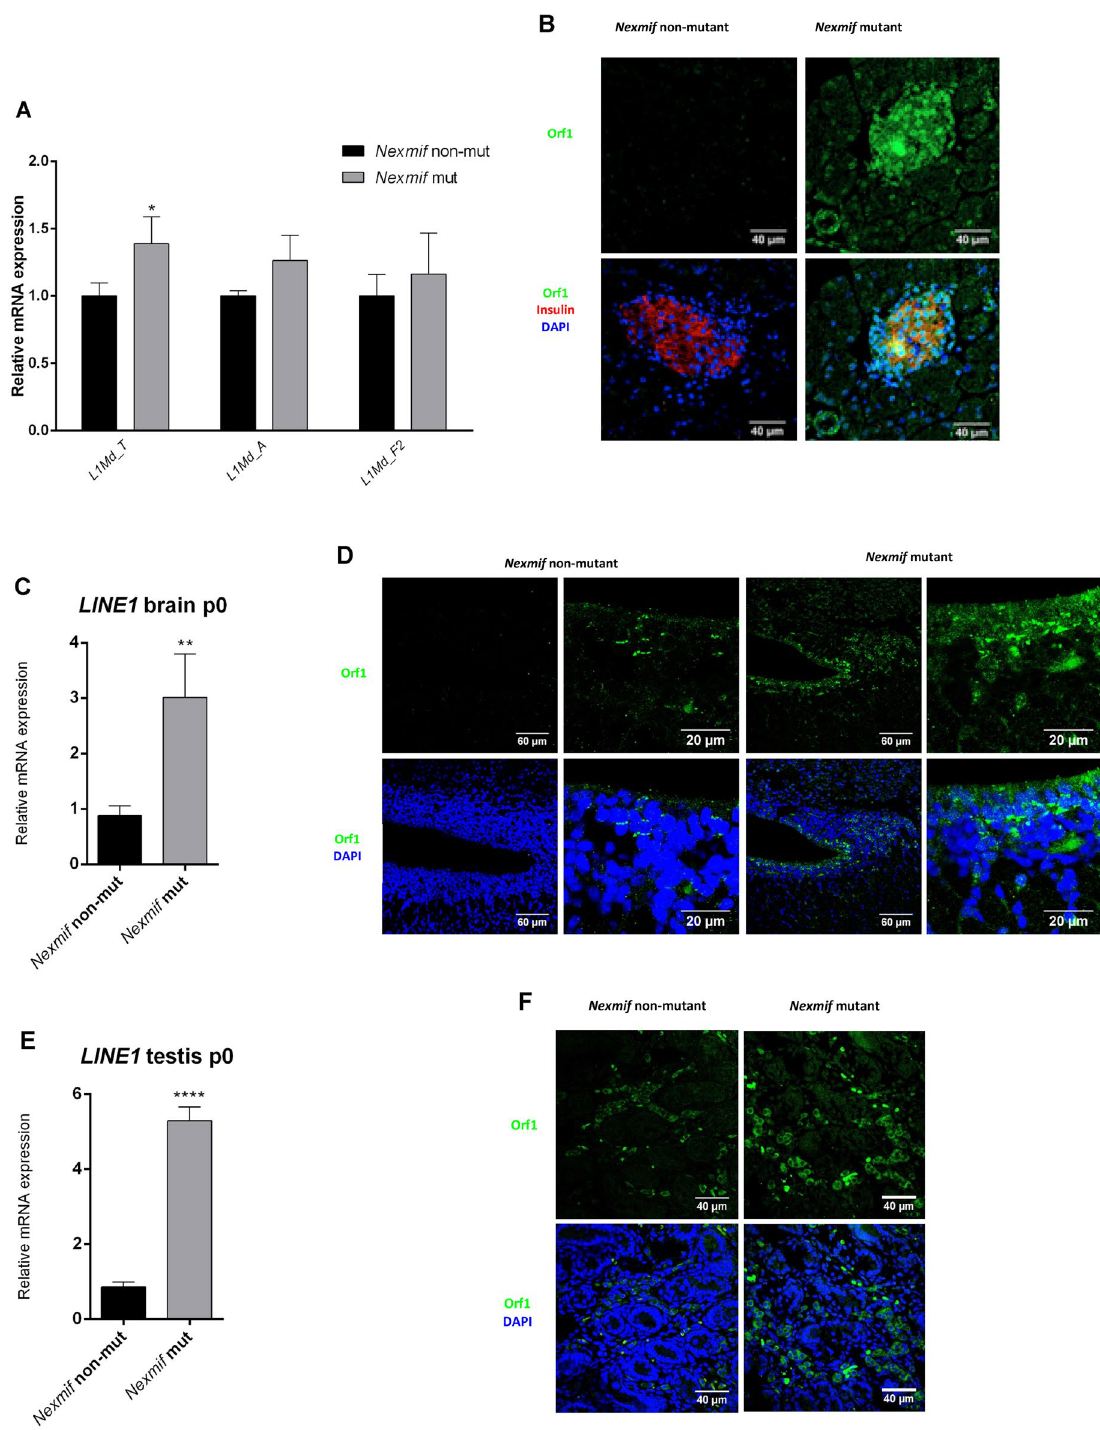
Figure 7. LINE1 activation. ( A ) RNAseq expression data for transposable LINE1 elements in pancreatic islets of 6-week-old Nexmif mutant and non-mutant mice (n = 3). ( B ) ORF1 protein (green) expression in Nexmif mutant and non-mutant mouse pancreas at postnatal day 21 by immunofluorescence. Insulin (red), DAPI (blue). ( C ) LINE1 mRNA expression in Nexmif mutant and non-mutant mouse brain at postnatal day 0 (n = 3). ( D ) ORF1 expression (green) in Nexmif mutant and non-mutant mouse brain (cortex) at postnatal day 0 by immunofluorescence. DAPI (blue). ( E ) LINE1 mRNA expression in Nexmif mutant and non-mutant mouse testis at postnatal day 0 (n = 3). **** P ≤ 0.0001. ( F ) ORF1 expression (green) in Nexmif mutant and non-mutant mouse testis at postnatal day 0 by immunofluorescence. DAPI